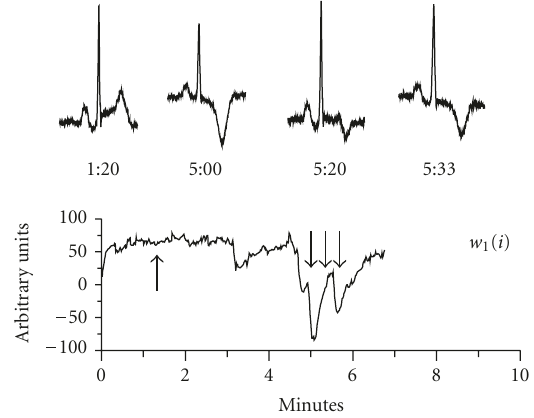
Figure 8: The series of the most significant KLT coe ffi cient w 1 ( i ) obtained from a patient undergoing balloon inflation in a coronary artery. The four beats (upper panel) correspond to the times indi- cated by the arrows on the w 1 ( i ) series (lower panel). Note that the ST-T segment is initially positive, as reflected by positive values of w 1 ( i ), but later changes polarity is inverted and exhibits consider- able variation in